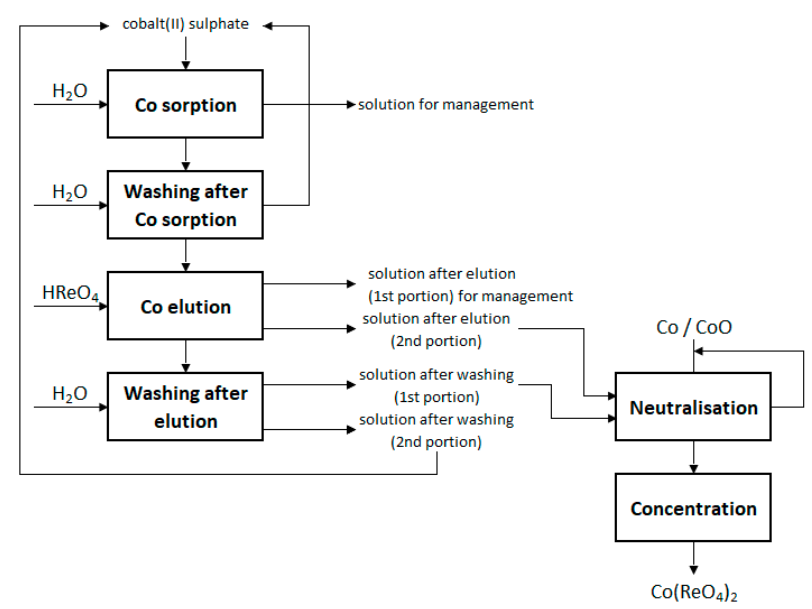
Figure 2. Scheme of Co(ReO 4 ) 2 preparation.